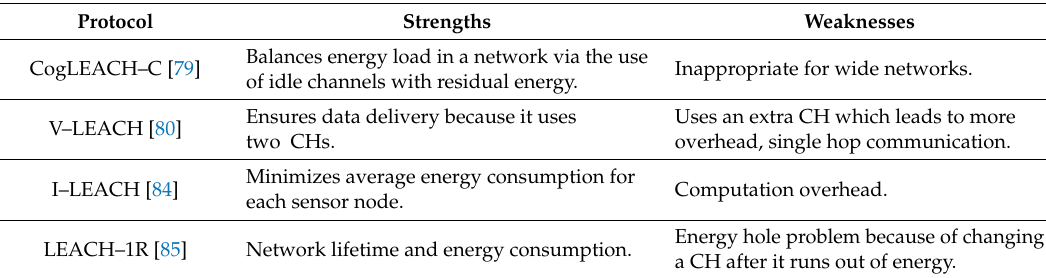
Table 4. Summary of residual-based CH selection